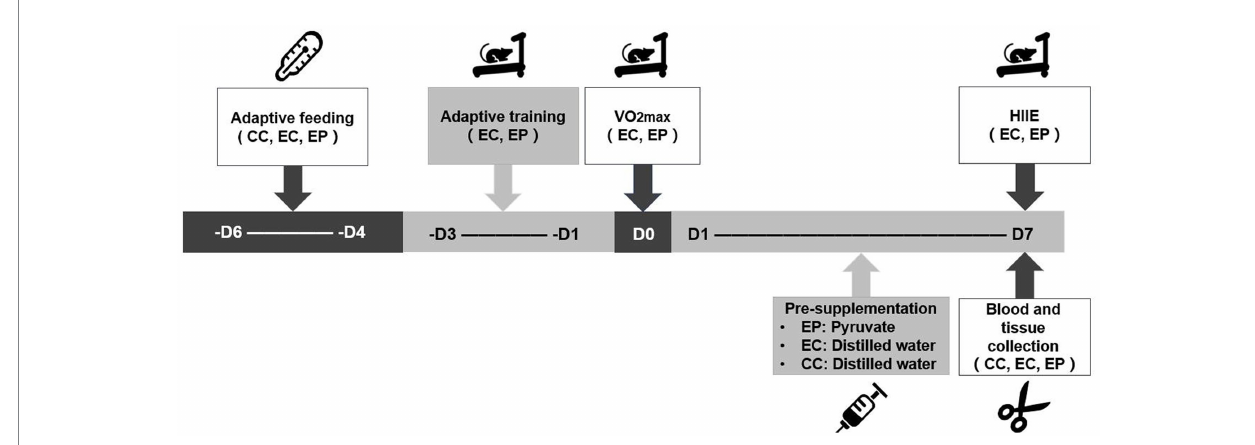
FIGURE 1 Experimental testing overview. VO 2max was completed prior to the experiment to determine the load intensity of the high-intensity interval exercise (HIIE). A 7-day pyruvate/distilled water supplementation was then completed prior to HIIE.